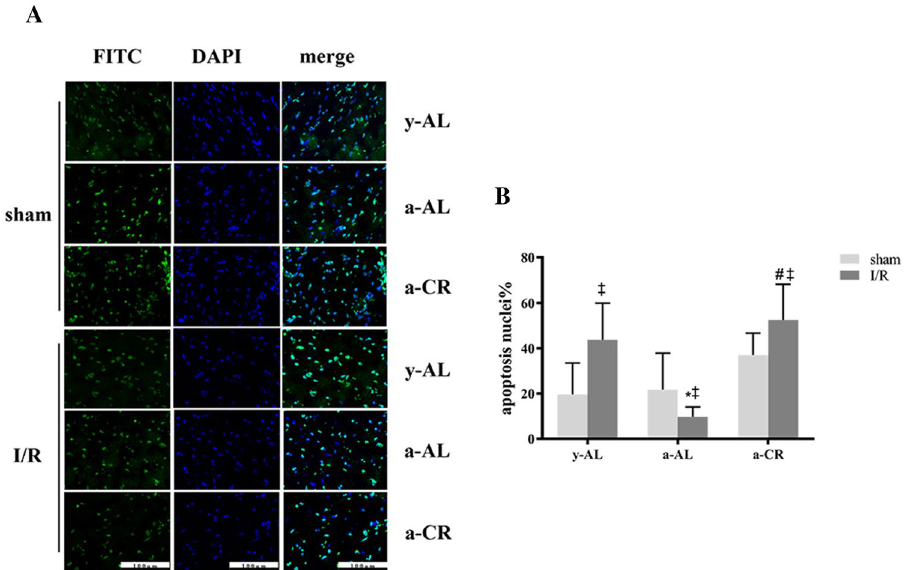
Figure 4. CR induces apoptosis in the peri-infarct myocardium of aged mice. ( A ) Representative images of apoptosis (in green) evaluated with TUNEL staining for. Nuclei were depicted by DAPI in blue. ( B ) Quantification of TUNEL positive (a) apoptotic cardiomyocyte nuclei in frozen sections from peri-infarct region after 24 h reperfusion. Data were from 6 randomly selected images. The group: y-AL young ad libitum group, a-AL aged ad libitum group, a-CR aged caloric restriction group. * P < 0.05 vs y-AL; # P < 0.05 vs a-AL; ‡ P < 0.05 vs sham